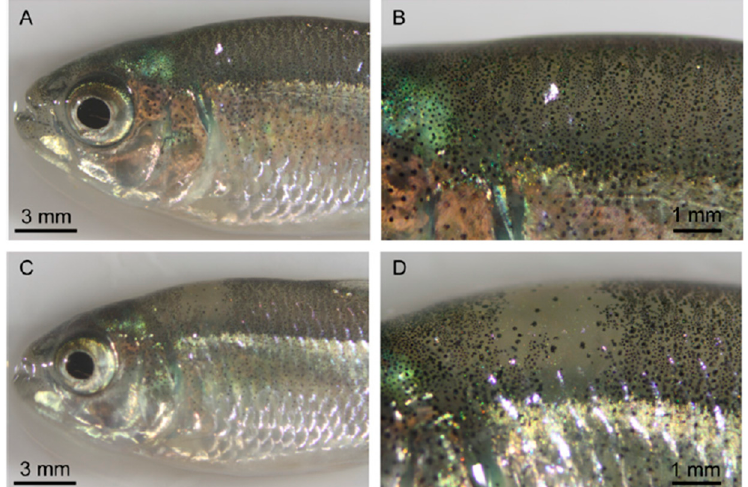
Figure 9. Interpretation of pigmentation in surface fish in oca2-injected F0s. The panels in Figure 9 present the following analysis. Panel ( A ) shows the pigmentation in an uninjected fish, whereas panel ( B ) depicts a close up of the dorsal region of uninjected surface fish from picture ( A ). Panel ( C ) illustrates the pigmentation in a 400 pg oca2 exon 9 injected F0 surface fish, whereas panel ( D ) shows a close up of a pigmentation patch lacking the melanin pigmentation from picture ( C ) [100].